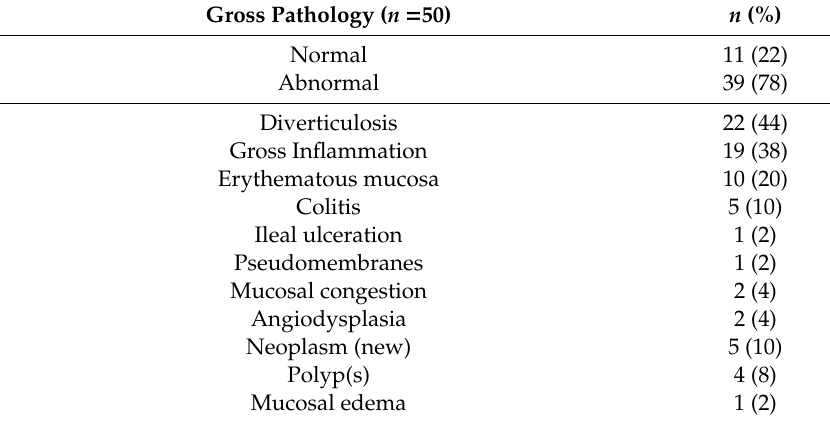
Table 5. Gross and microscopic pathology at colonoscopy.